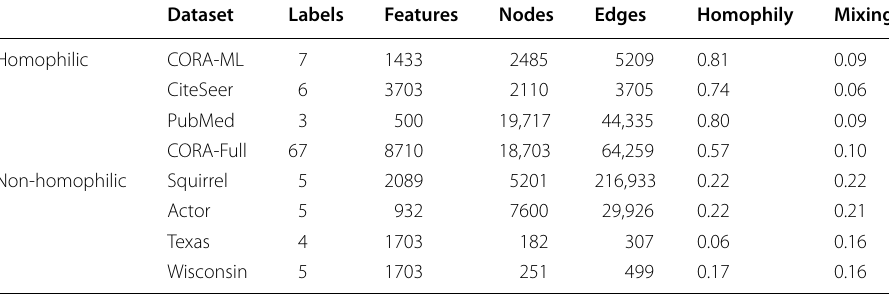
Table 2 Dataset statistics after preprocessing (similar to Shchur et al.